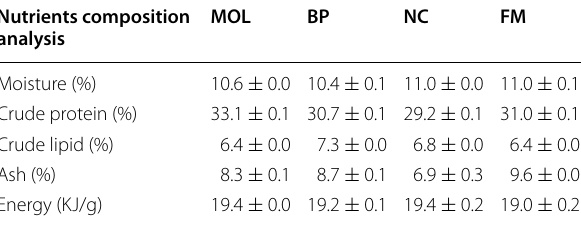
Table 3 Analyzed nutrients composition of MOL, BP, NC and FM diets Nutrients composition